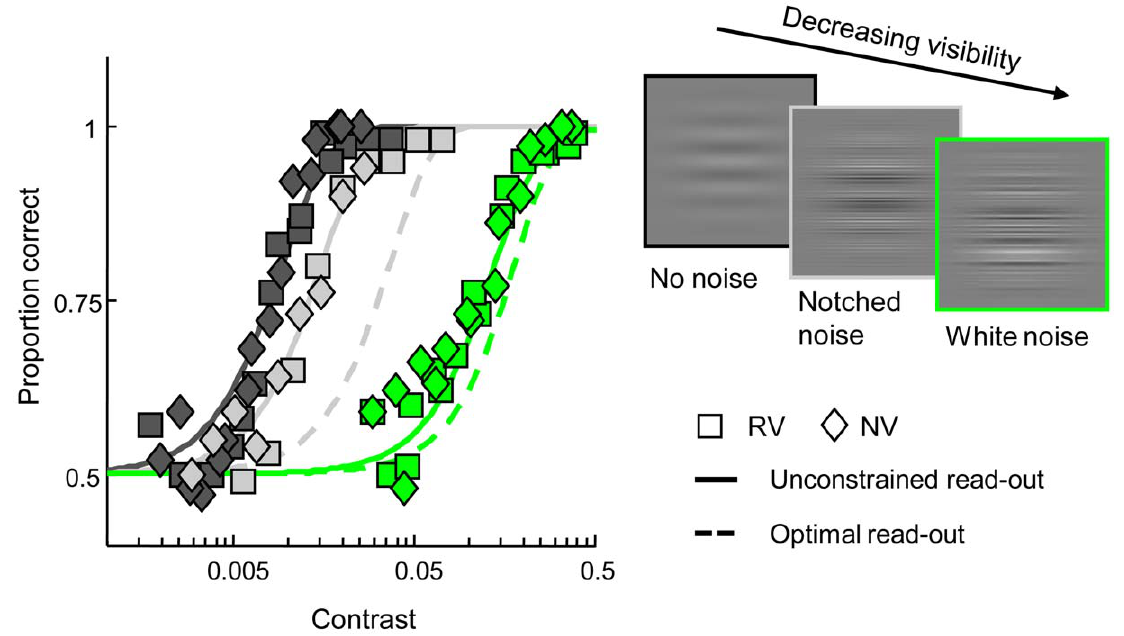
Figure 3. Contrast detection data and model fits. White noise (green) impairs detection performance considerably, while detectability in notched noise (gray) and in the absence of external noise (black) are approximately equal. Symbols indicate the pooled data of individual observers. Full lines represent the fit of our population code model in which likelihood read-out function width is a free parameter. Broken lines denote the fit when narrow read-out functions are assumed in the same model. Our population code model captures contrast detection performance in all conditions when low-precision likelihood read-out is assumed (full lines). The same model implementing high-precision read-out underestimates grating detectability in notched noise and white noise (broken lines).